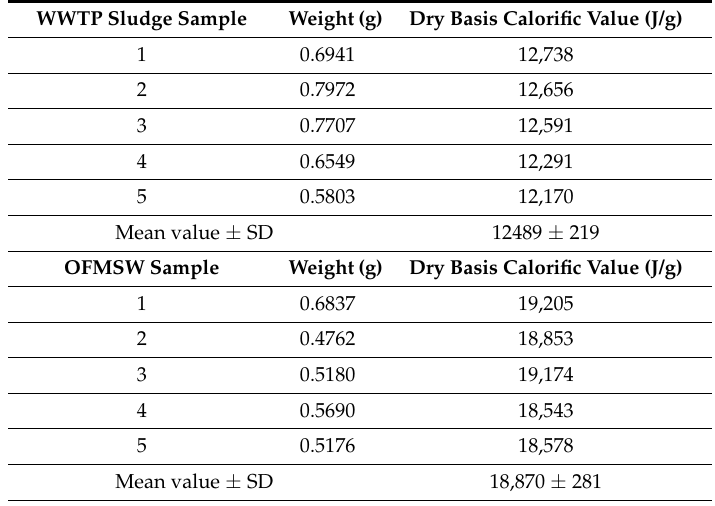
Table 2. The dry-basis calorific values of the OFMSW and the wastewater treatment plant (WWTP) sludge.